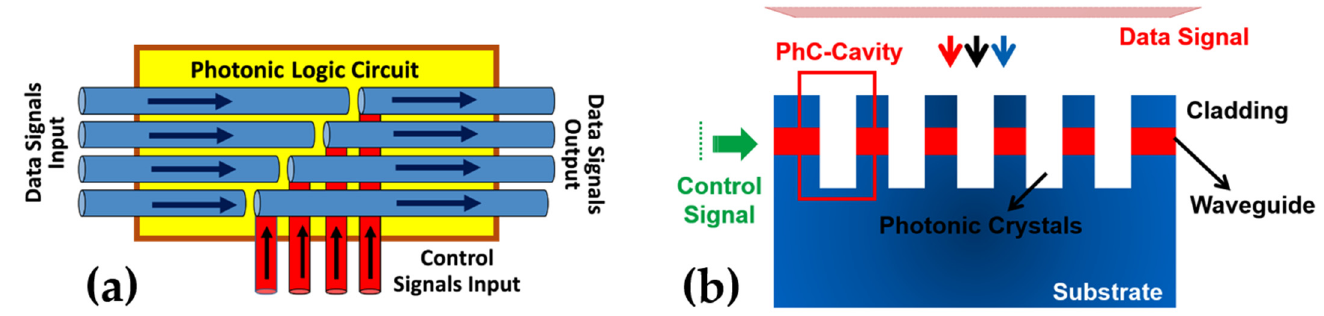
Figure 1. ( a ) Conceptual design of the optical switches in a photonic logic circuit ( b ) Schematic of the designed optical switch.